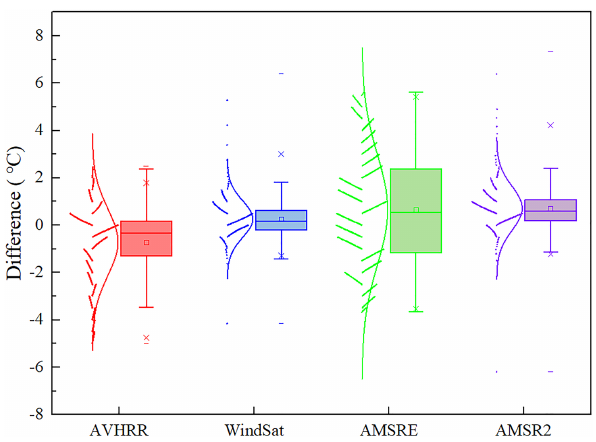
Figure 2. Box chart with scatters of the differences in the original MODIS and multisource daily SSTs (AVHRR, WindSat, AMSR- E, AMSR2). The boxes are determined by the 25th and 75th per- centiles. The whiskers are determined by the 5th and 95th per- centiles. The data are plotted as scatters on the left of each box. A curve corresponding to a normal distribution is also displayed on top of each scatter